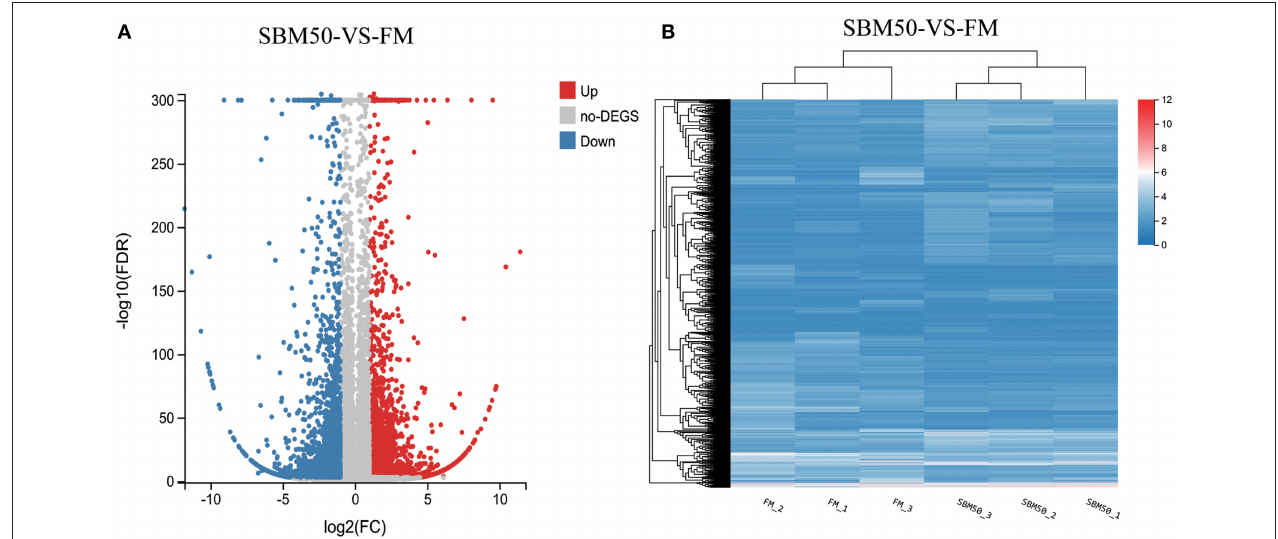
FIGURE 2 | Volcano plot (A) and hierarchical cluster (B) analysis of differentially expressed genes (DEGs) in the FM and SBM50 groups. (A) Each point in the figure indicates a gene, the horizontal axis indicates the numerical value of DEGs, and the vertical axis indicates the negative logarithm of P -value-FDR. Red and blue dots represent the upregulation and downregulation of DEGs, respectively. Gray dots represent no differential expression of genes. (B) The color indicates the level of gene expression. Red and blue colors represent the high and low expression of genes,